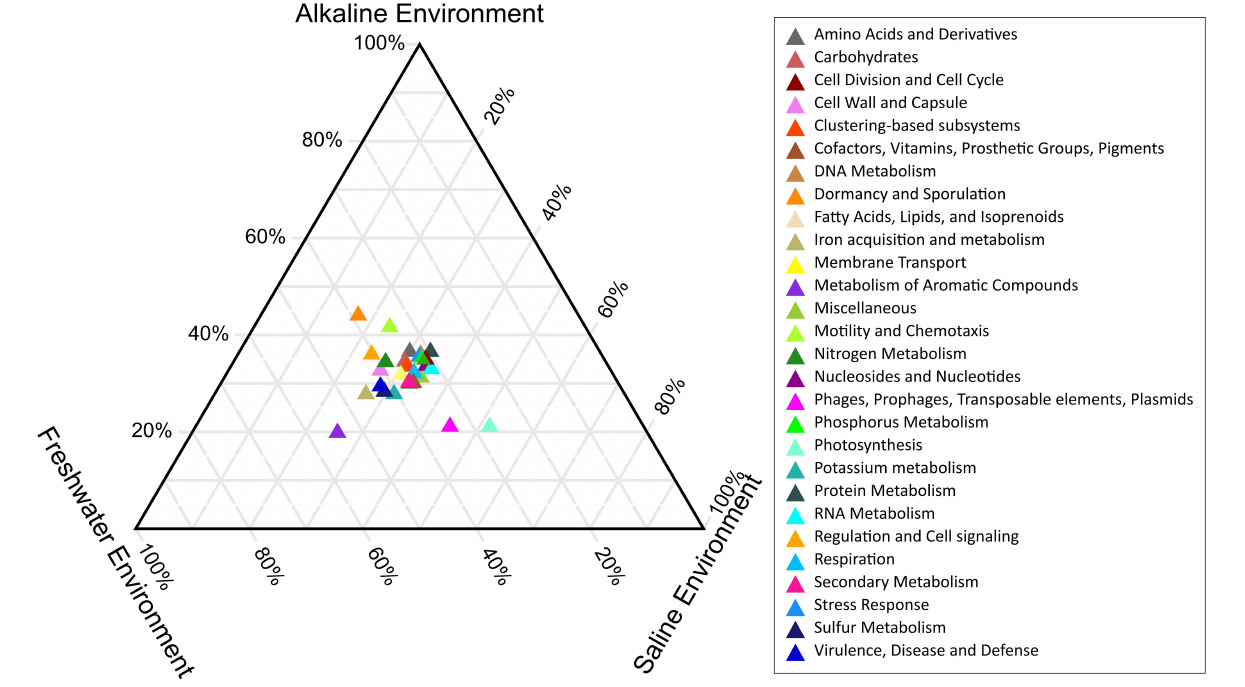
FIGURE 5 | Ternary plot indicating the differentially abundant metabolic features of saline, freshwater, and alkaline ecosystem identified with subsystem annotated metabolic features at hierarchy level